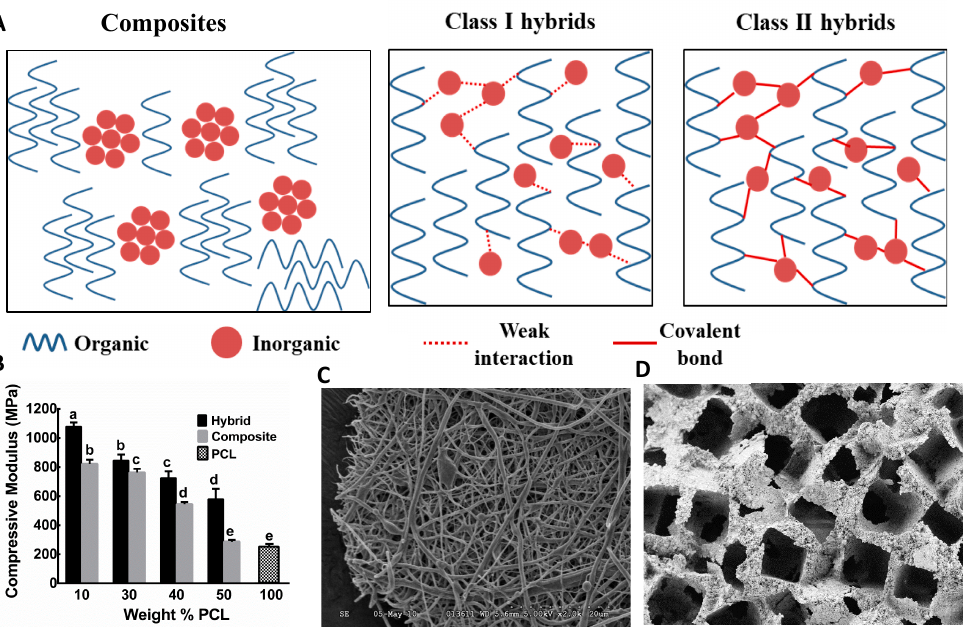
Figure 2. ( A ) Interaction between phases in composites and organic-inorganic (O/I) hybrid materials ( B ) compressive modulus of class II PCL–BPSG (borophosphosilicate glass) hybrid compared to composite of PCL and BPSG and PCL alone [146] ( C ) SEM image of electrospun class I PCL-tertiary bioactive glass (unpublished data from Mequanint Lab) ( D ) class II PCL–BPSG hybrid scaffold fabricated